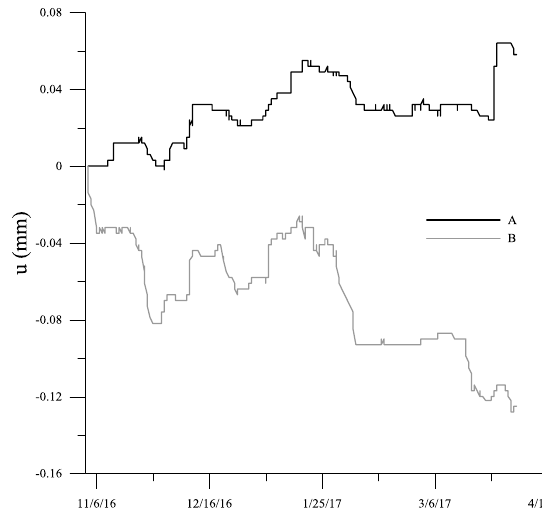
Figure 12. Crack width (mm) of the two instruments installed on the two longitudinal walls (A west wall; B: east one), near the northern part of the